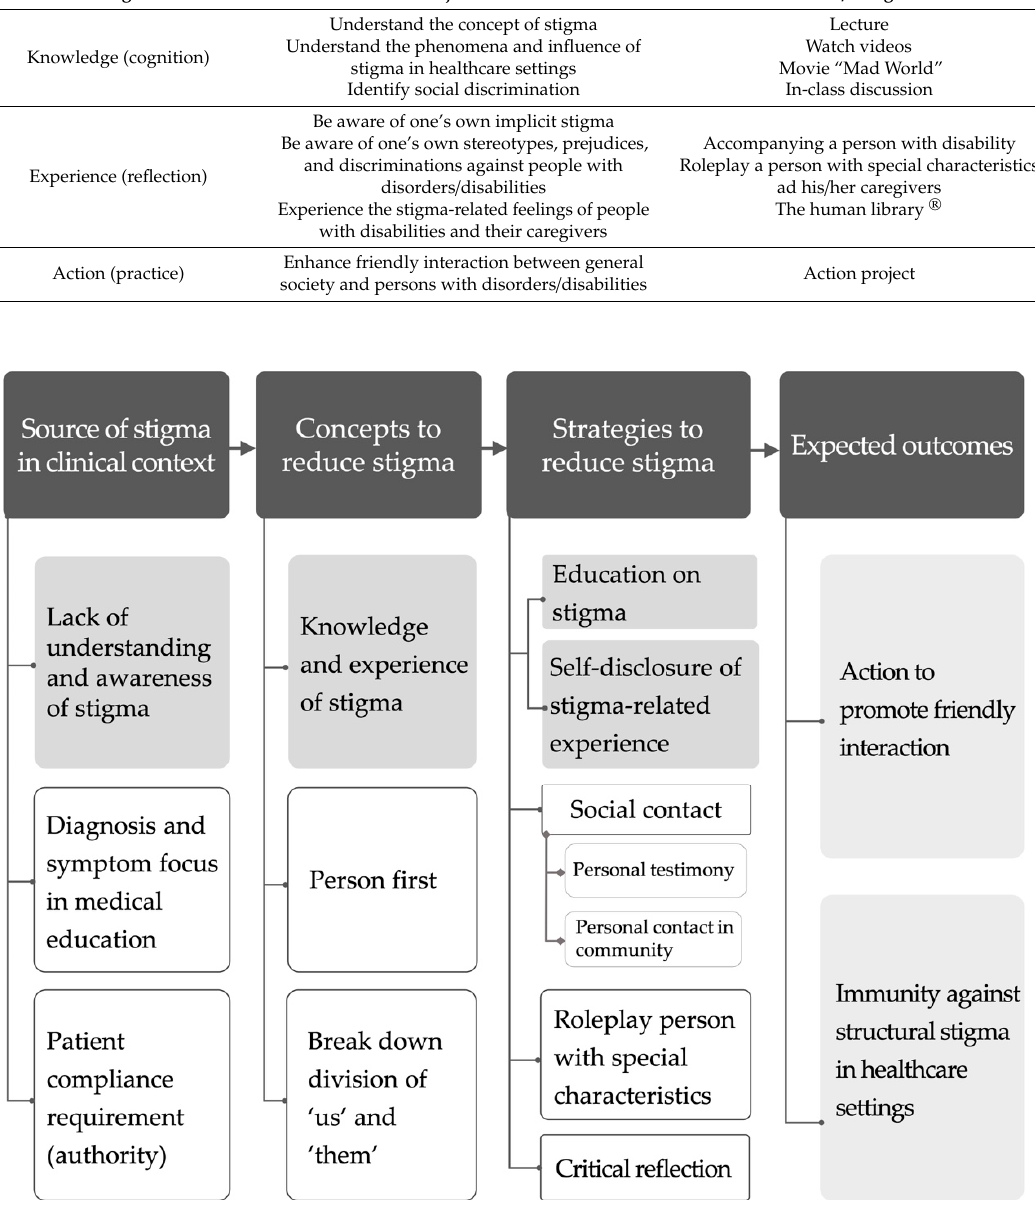
Figure 1. Themes constructed from focus-group interview transcript to develop the anti-stigma course for occupational therapy